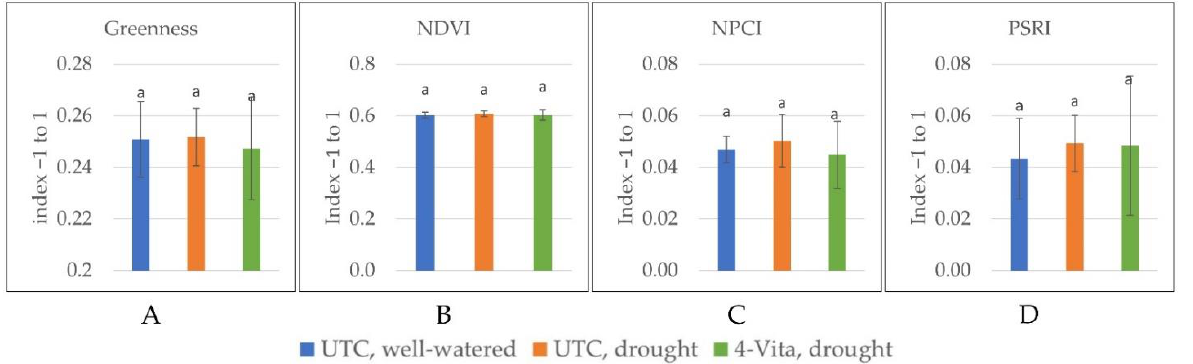
Figure 3. Physiological parameters observed 4 DAT by the LLPhP (scanning platform). ( A ) Greenness (green leaf index, GLI), ( B ) NDVI, ( C ) NPCI, ( D ) PSRI. For each trait, at least one letter in common indicates no significant difference.